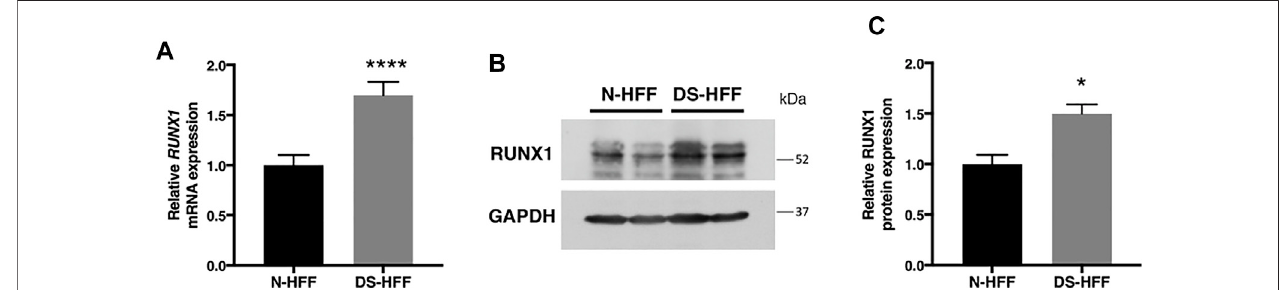
FIGURE1| RUNX1expressionissigni fi cantlyincreasedinDS-HFFs vs. N-HFFs. (A) Relative RUNX1 mRNAexpressionmeasured byqRT-PCRandnormalizedto a reference gene ( GAPDH ). Values represent the average determination from at least 2 qRT-PCR experiments. Results are expressed as relative mean values ± SEM of cell cultures from four euploid and four trisomicsamples. (B) Representative immunoblot ofRUNX1 protein detected intotal protein fractions oftwo N-HFF and two DS- HFF samples. GAPDH wasused asaloading control. (C) Densitometricanalysis from three different experiments. Results areexpressed asrelativemean values ± SEM from three euploid and three trisomic samples. * p -value < 0.05, **** p -value ≤ 0.0001.